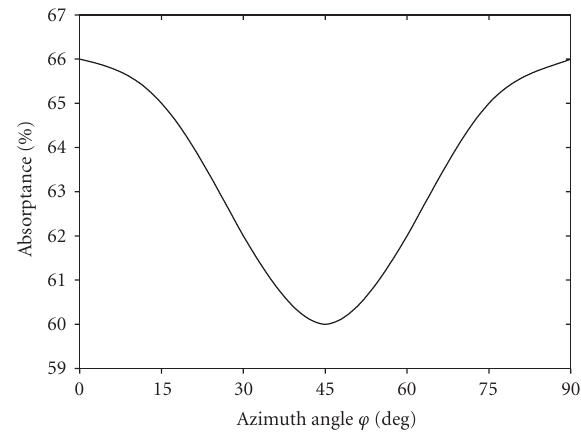
Figure 7: The position of the triangle of principal orientations. The incident angle θ and the azimuth angle ϕ are demonstrated.